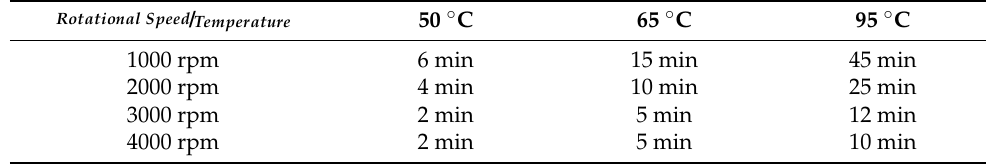
Table 1. Soft bake temperatures and times for SU-8 2075.